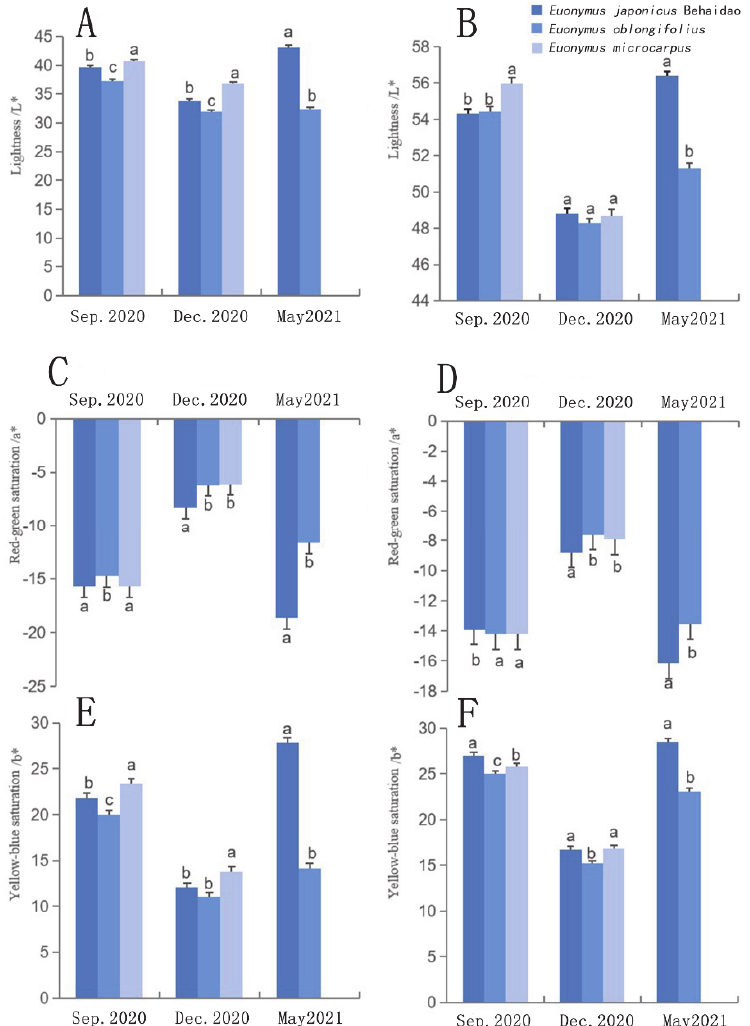
Figure 3. Changes in leaf surface color difference in three Euonymus species. ( A ) lightness of the upper surface; ( B ) lightness of the lower surface; ( C ) red-green saturation of the upper surface; ( D ) red-green saturation of the lower surface; ( E ) yellow-blue saturation of the upper surface; ( F ) yellow-blue saturation of the lower surface; a, b and c represented significant differences.